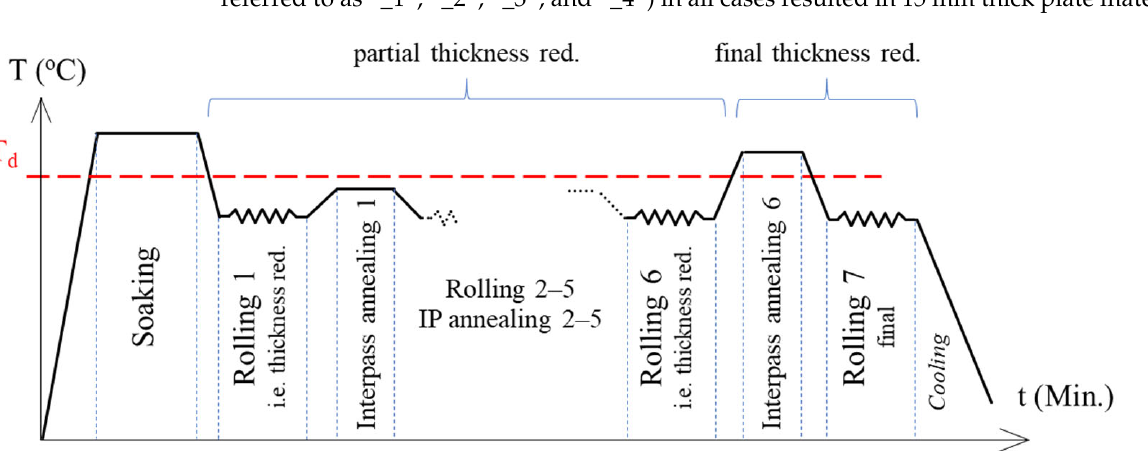
Table 1. Chemical compositions (in wt.%) of the ferritic trial alloys.